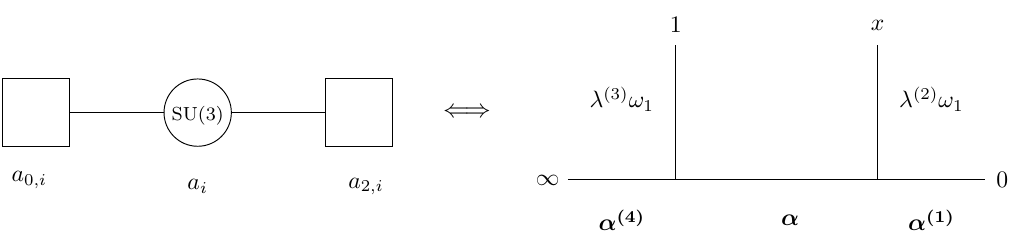
Figure 1 . On the left: the quiver diagram for the conformal SU(3) gauge theory with 6 fundamental hypermultiplets. On the right: the dual W 3 conformal